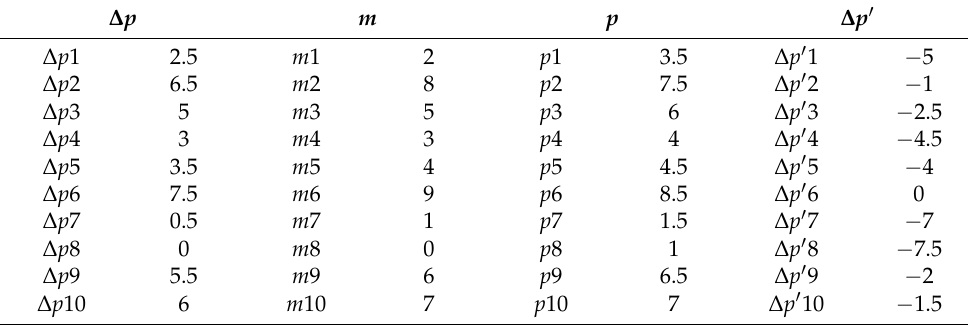
Table 4. The values of the elements for the calculation of the weighting coefficients.